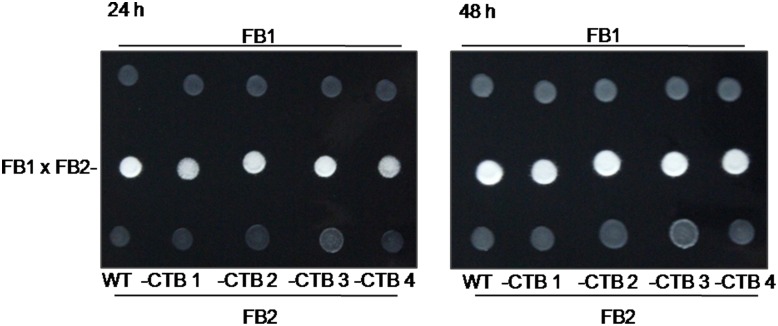

U. maydis FB2-CTB strains develop fuzzy colonies when are paired withthe FB1 strain.FB2-CTB transformants were co-spotted with their mating partner FB1 strain on a charcoal-containing MM plates. The FB2 x FB1 cross was tested as control. Photos were taken 24 and 48 h after incubation at room temperature.